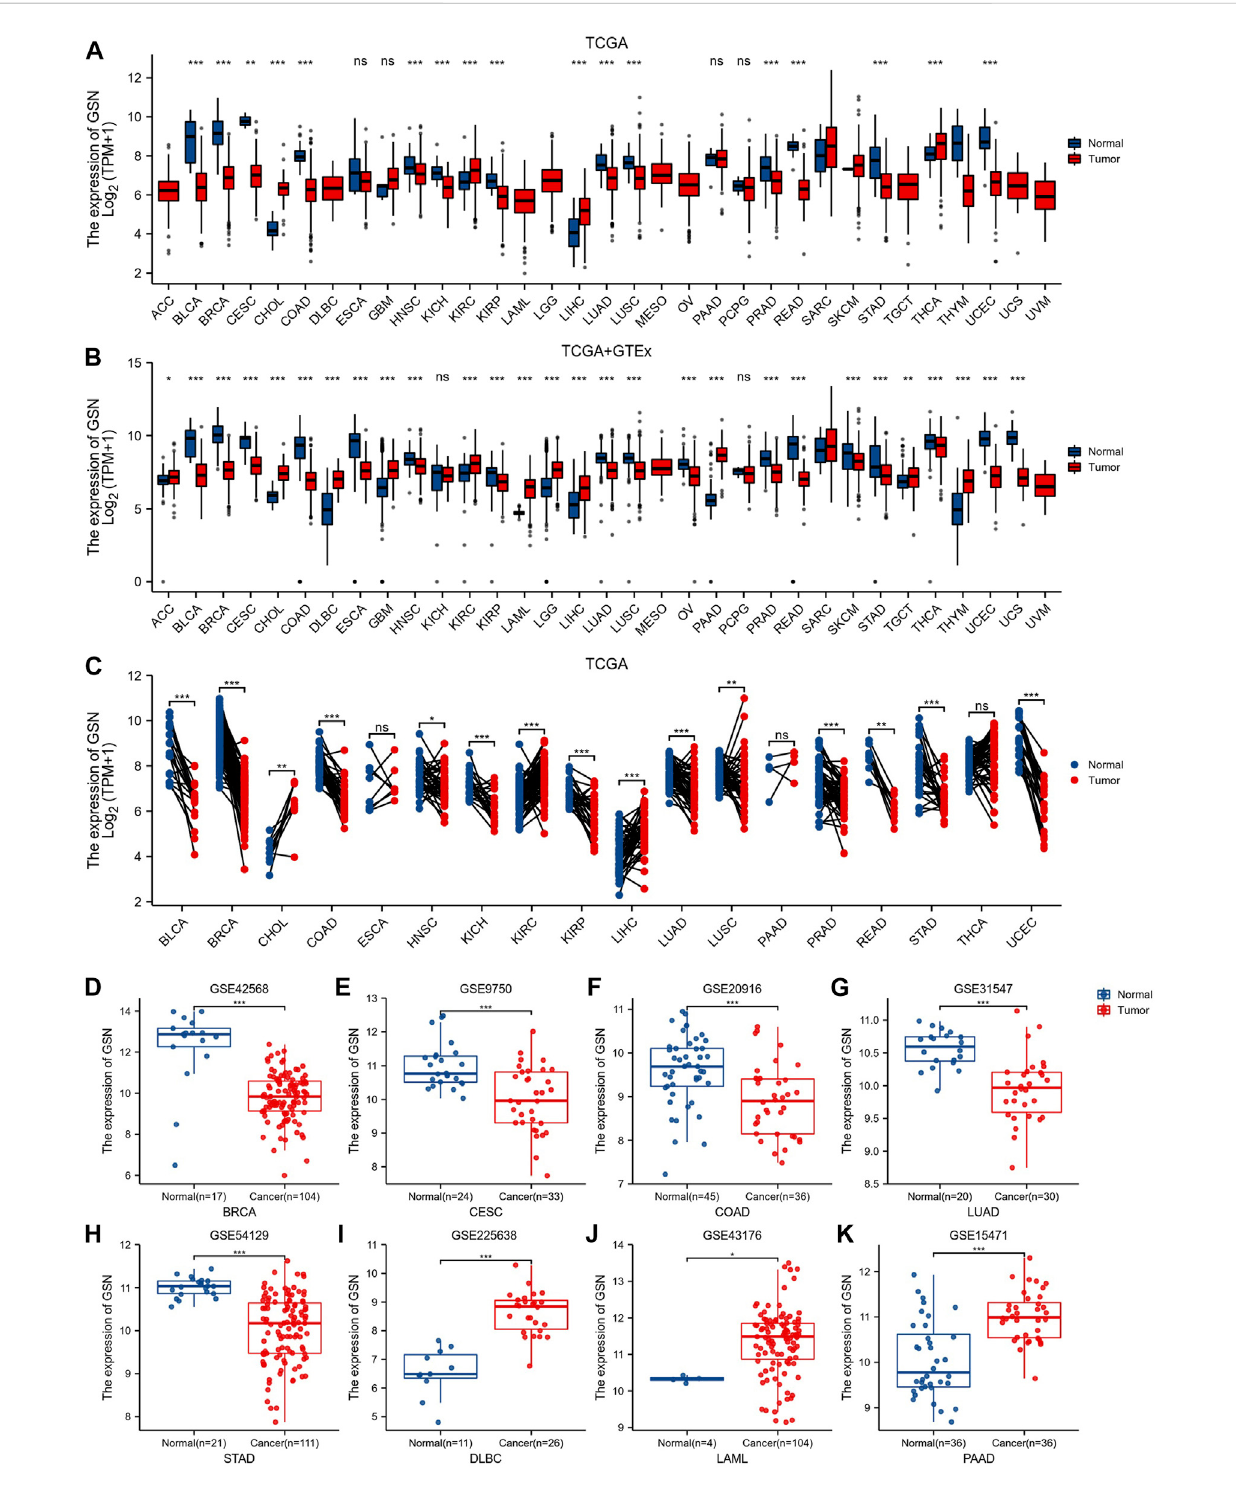
FIGURE 1 Differences in GSN expression in 33 cancers. (A) GSN mRNA expression difference between TCGA tumor and normal tissues. (B) GSN mRNA expression difference between tumor and normal tissues with data from the TCGA and GTEx. (C) GSN mRNA expression in TCGA tumor and paired normal tissues. The differential expression of GSN was analyzed using BRCA (GSE42568) (D) , CESC (GSE9750) (E) , COAD (GSE20916) (F) , LUAD (GSE31547) (G) , STAD (GSE54129) (H) , DLBC (GSE225638) (I) , LAML (GSE43176) (J) , and PAAD (GSE15471) (K) datasets in GEO databases. (* p < 0.05, ** p < 0.01, *** p <